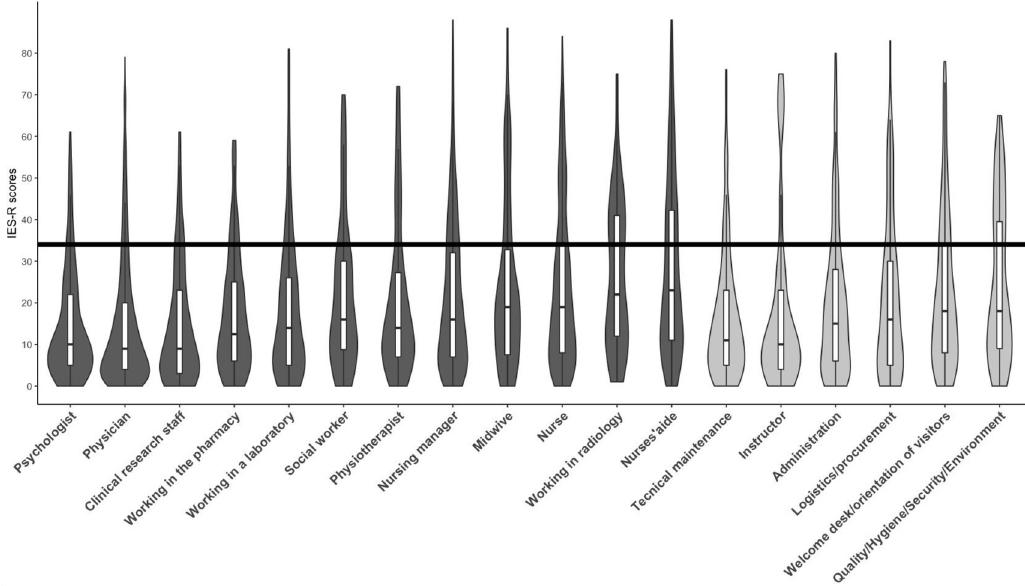
Fig 3. Histogram and quartiles of IES-R scores according to profession. The black line represents the threshold value of IES-R scores indicative of the possible presence of post-traumatic stress disorder at one month after the event. Medical/caregiving professions are shown in dark grey, and non-medical professions in light grey.